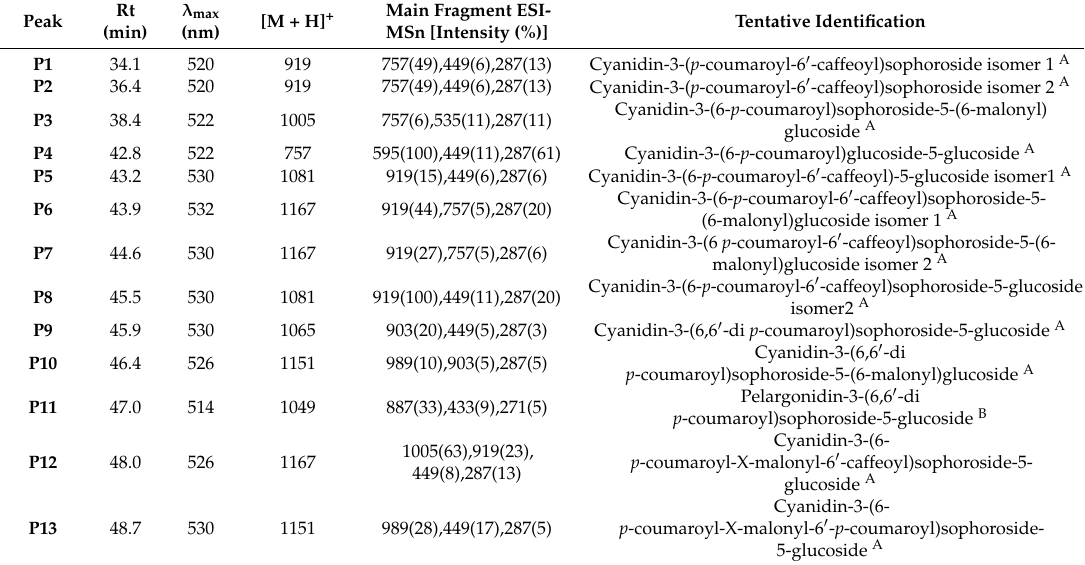
Table 1. Retention time (Rt), wavelengths of maximum absorption in the UV-Vis region ( λ max ), and tentative identification of anthocyanin compounds in O. basilicum var. purpurascens (mean ± SD). Peak